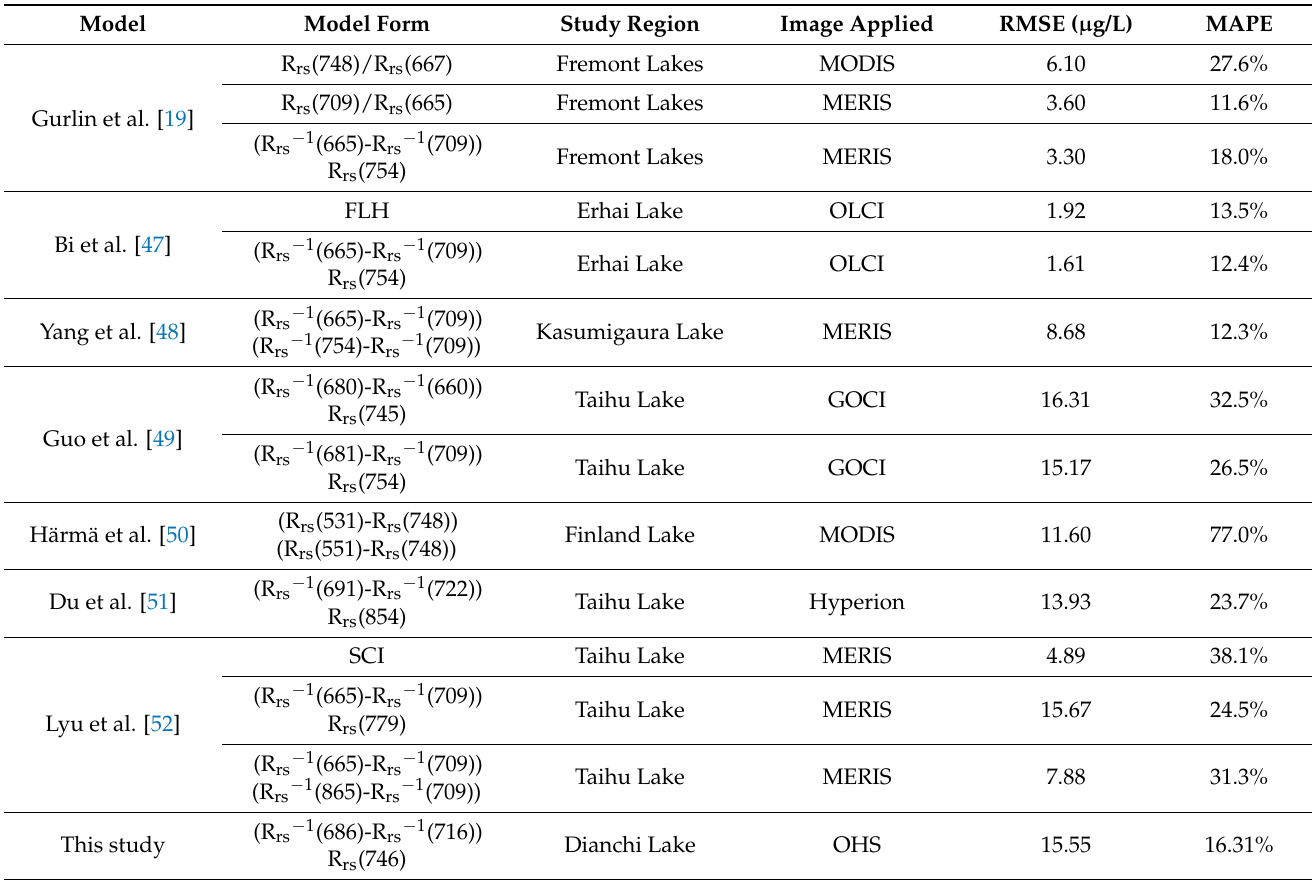
Table A2. Comparison between this study and existing Chl-a concentration inversion algorithms and commonly used ocean color satellite images. GOCI represents Geostationary Ocean Color Imager; OLCI describes Ocean and Land Colour Instrument; SCI stands for Synthetic Chlorophyll Index algorithm.